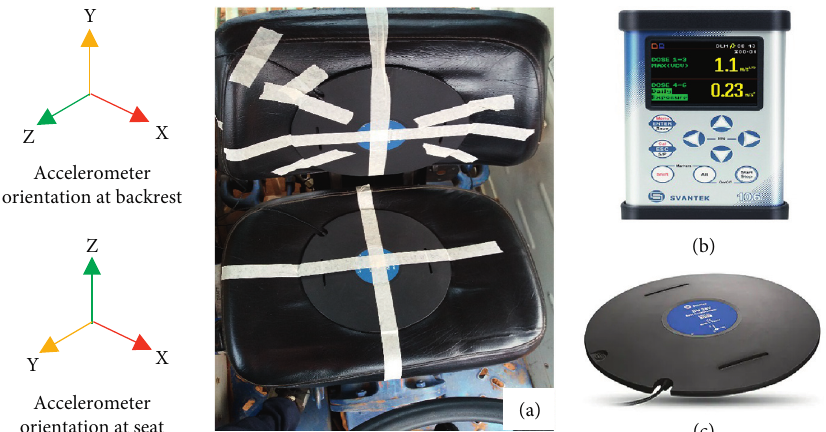
Figure 2: (a) Representation of experimental setup; (b) SV 106 six-channel human vibration meter and analyzer; (c) SV 38V- seat pad accelerometer.